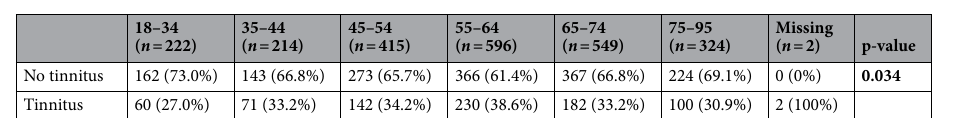
The association between SSQ12 scores and tinnitus presence is presented in Table 5 (Model 1). Recipients with tinnitus had significantly lower SSQ12 scores than recipients without tinnitus (mean difference − 0.71 [SD: 0.09], F-test, p < 0.001, Supplemen- tary Fig. S1) after adjusting for age and presence of unilateral/bilateral implants. Using tinnitus presence as a predictive factor, Model 1 explained significantly more of the variability in SSQ12 scores compared with the simplest Model 0, using only age and unilateral versus bilateral implants as predictors ( Model 0 (R 2 = 3.4%) vs Model 1 (R 2 = 5.9%), ANOVA test, p < 0.001, Table 5). Association between hearing‑related QoL and self‑reported tinnitus annoyance. The associa- tion between SSQ12 scores and tinnitus annoyance is presented in Table 5 (Model 2). SSQ12 scores significantly decreased with increased tinnitus annoyance (Jonckheere-Terpstra test, p < 0.001, Supplementary Fig. S2). Fig-